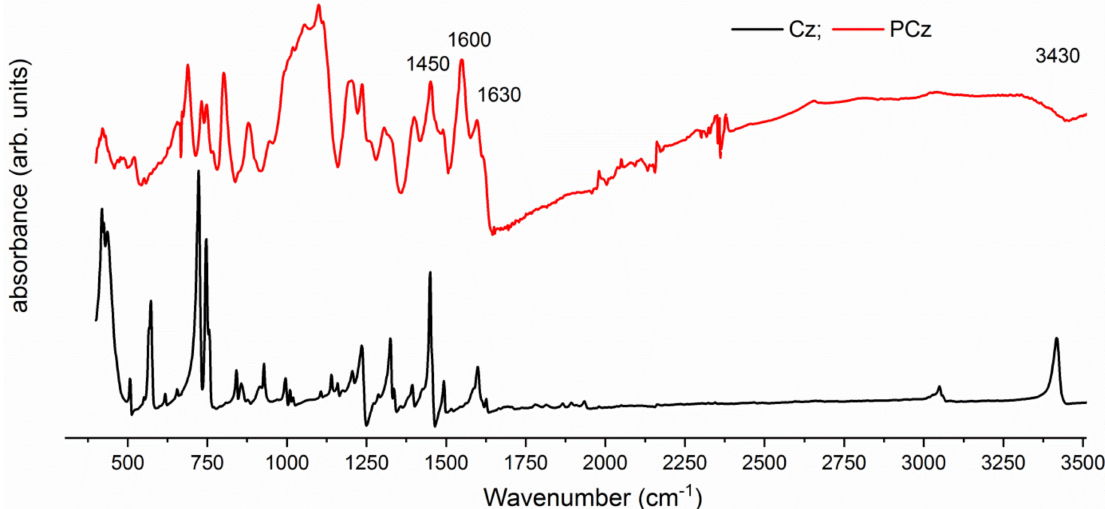
Figure A2. IR-ATR of carbazole (black line) and electrochemical polymerised polycarbazole (red